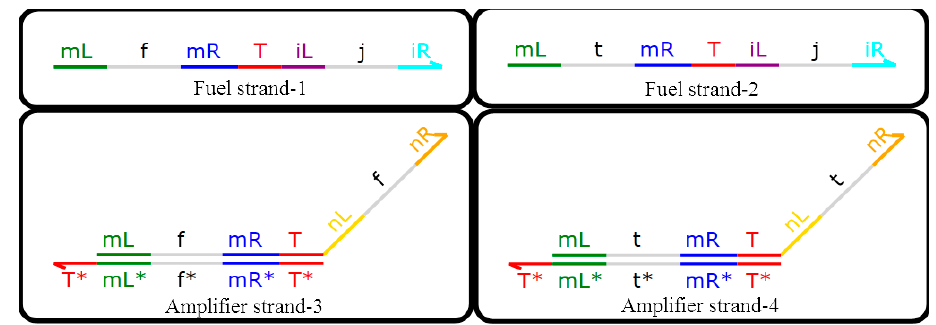
Figure 5. Amplification gate with a domain label.